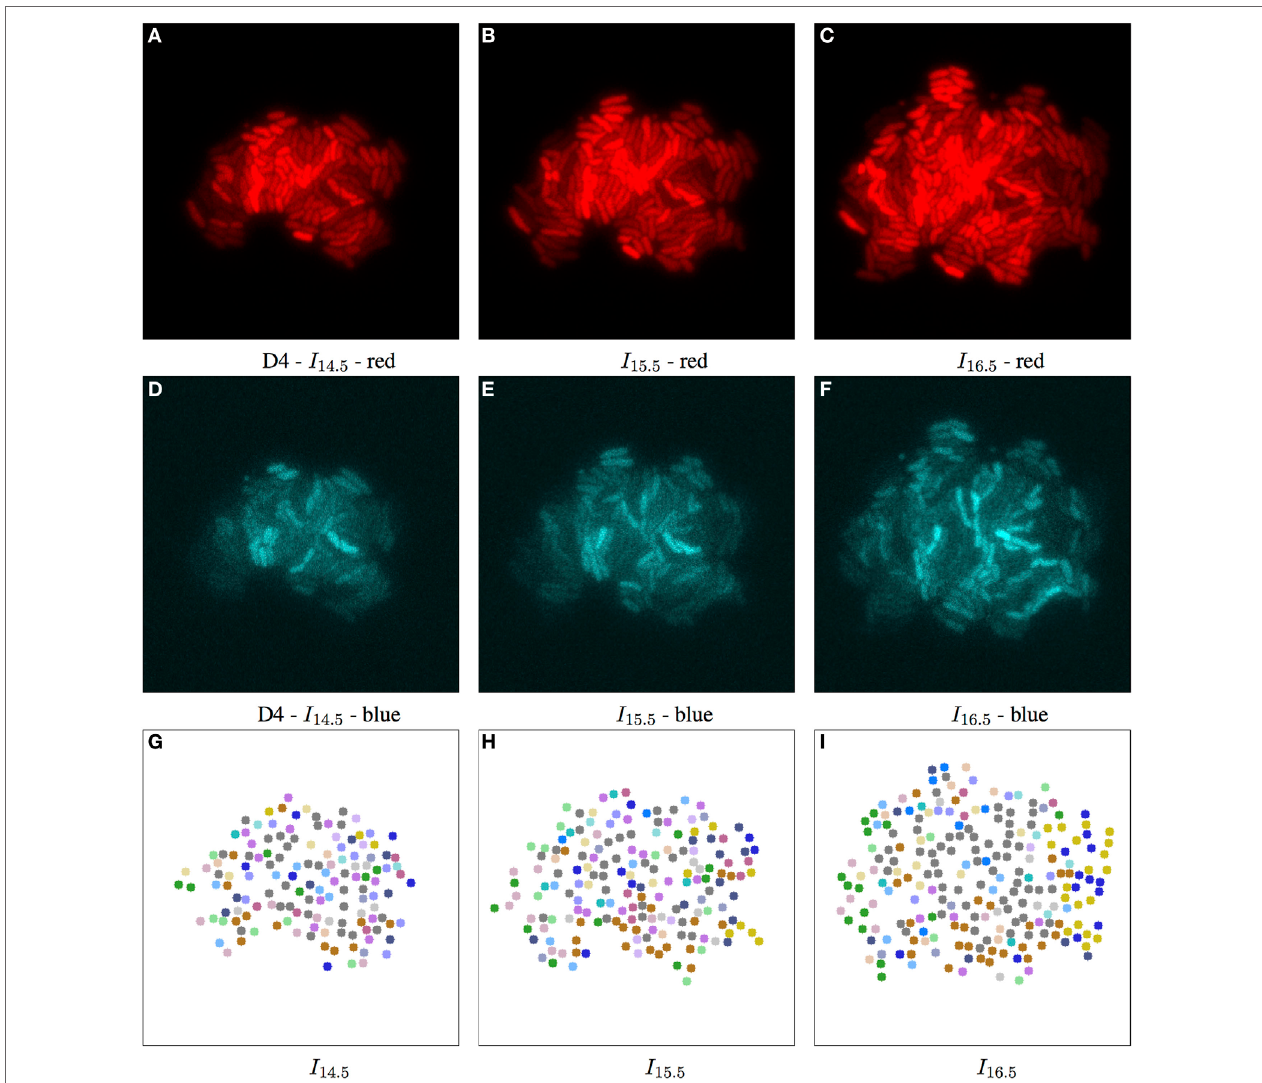
Figure 7 | Biomovie D4 with RGB channels of image points 14.5, 15.5, and 16.5 h, and their corresponding patch structure, respectively. Enhanced exposures for red: 60% and blue channels: 90%. As seen in Figure 3, the biomovie showcases bio-engineered S. meliloti bacterial cells fluorescing in a particular way: The red (a–c) and blue channels (D–F) show certain behavior in response to changes of conditions; here the bacterial cells are of wild type, and exposed to high concentrations of phosphate, influencing bacterial communication. The green channel is omitted due to its homogenous fluorescence. The patch structure is found using the following thresholds: geometric distance 100 px, and specific channel differences of red: 20, green: 50, and blue: 50. Main images show 7-px dots at computed particle locations. (g–i) The split/merge computation has been run, and particles are colored by their patch